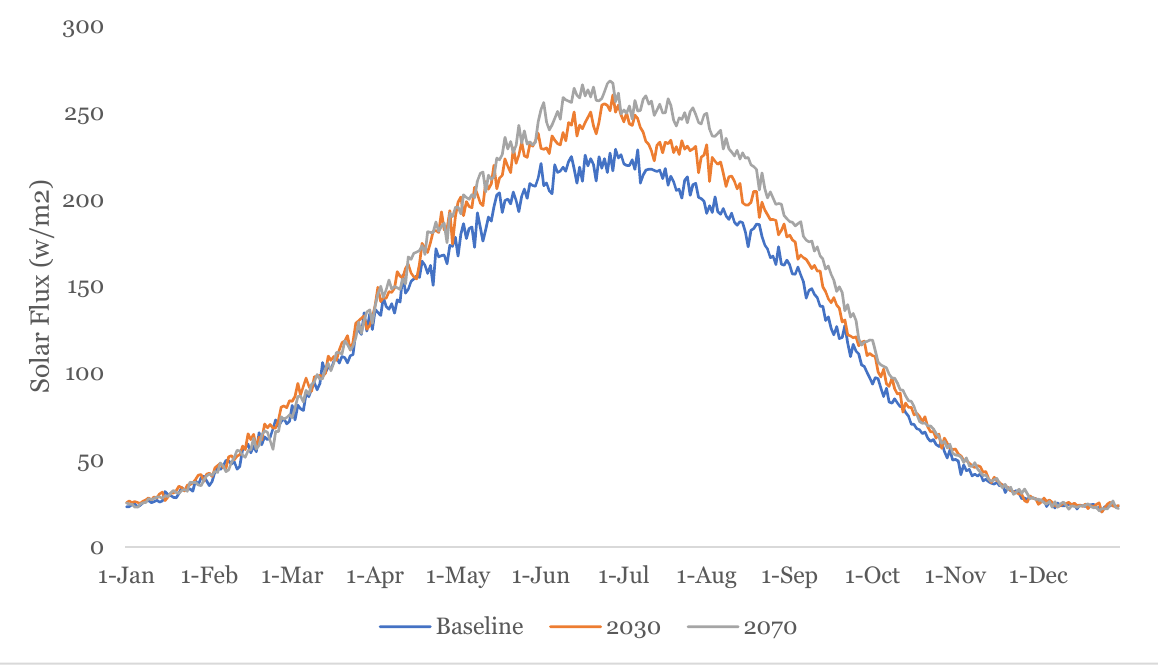
Figure 2. Annual profile of daily average solar flux in Cardiff for baseline, 2030 and 2070 .